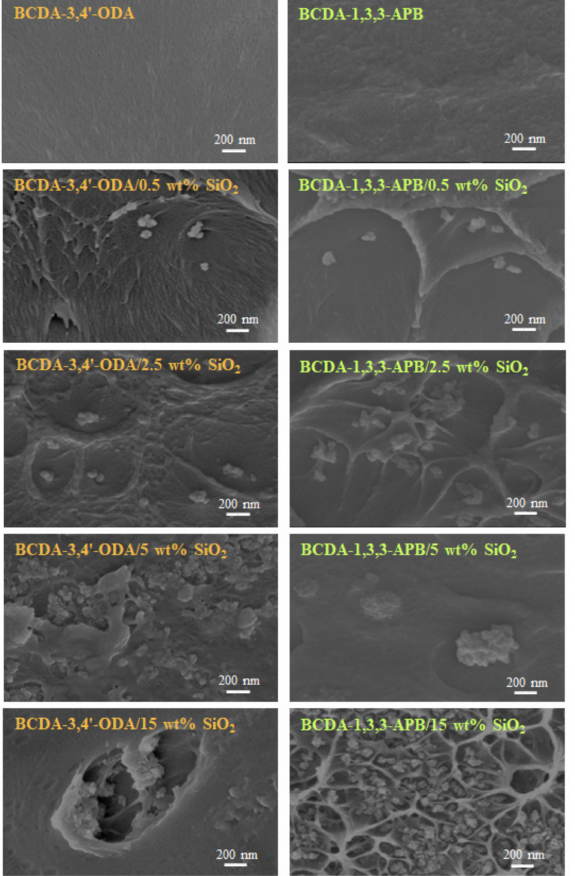
Figure 5. FE-SEM images of pristine alicyclic PI membranes and their related PI/SiO 2 mixed matrix